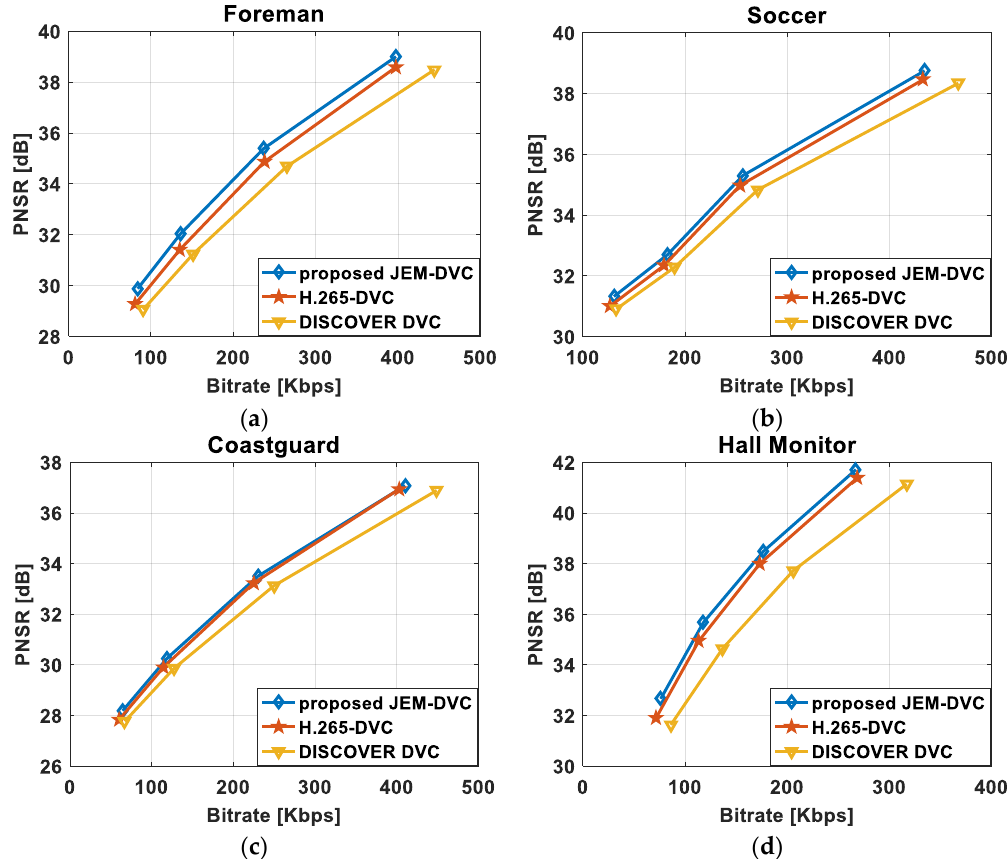
Figure 11. Comparisons of overall rate-distortion (RD) performance obtained by H.265-DVC, DISCOVER DVC, and the proposed JEM-DVC with different test sequences: ( a ) Foreman , ( b ) Soccer , ( c ) Coastguard , and ( d ) Hall Monitor .